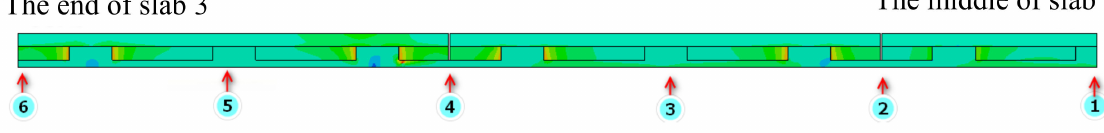
Figure 8. Layout of track slab displacement measuring